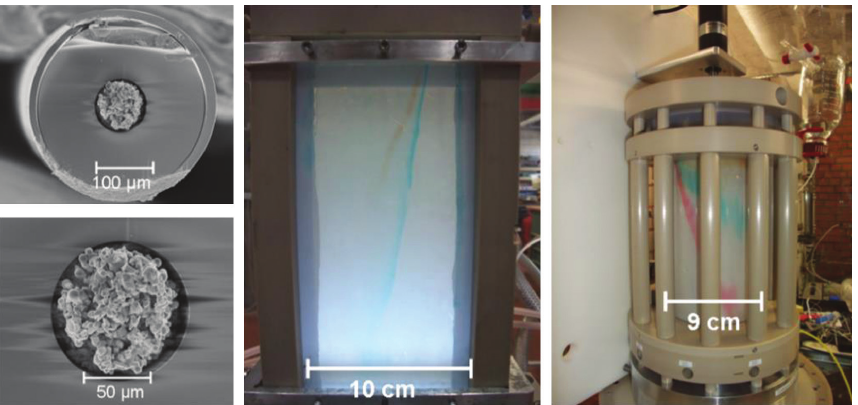
Figure 3 Pictures of a CEC capillary (right), the planar test system (middle) and the annular prototype (left) filled with monolithic stationary phase.